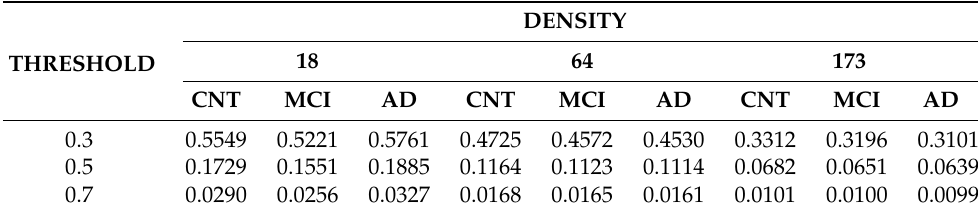
Table 3. Mean Connection Density values of CNT, MCI, and AD for all electrode configurations for three threshold